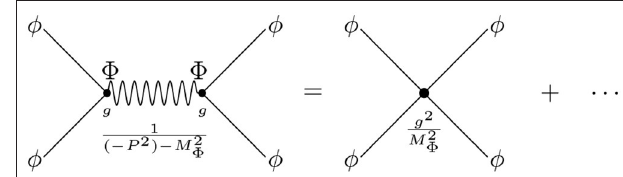
FIGURE 3 | In the diagrammatic representation, to first order in the expansion (80), the 8 -propagator is shrunk to a point, leading to an effective four-point contact interaction between the φ -fields.